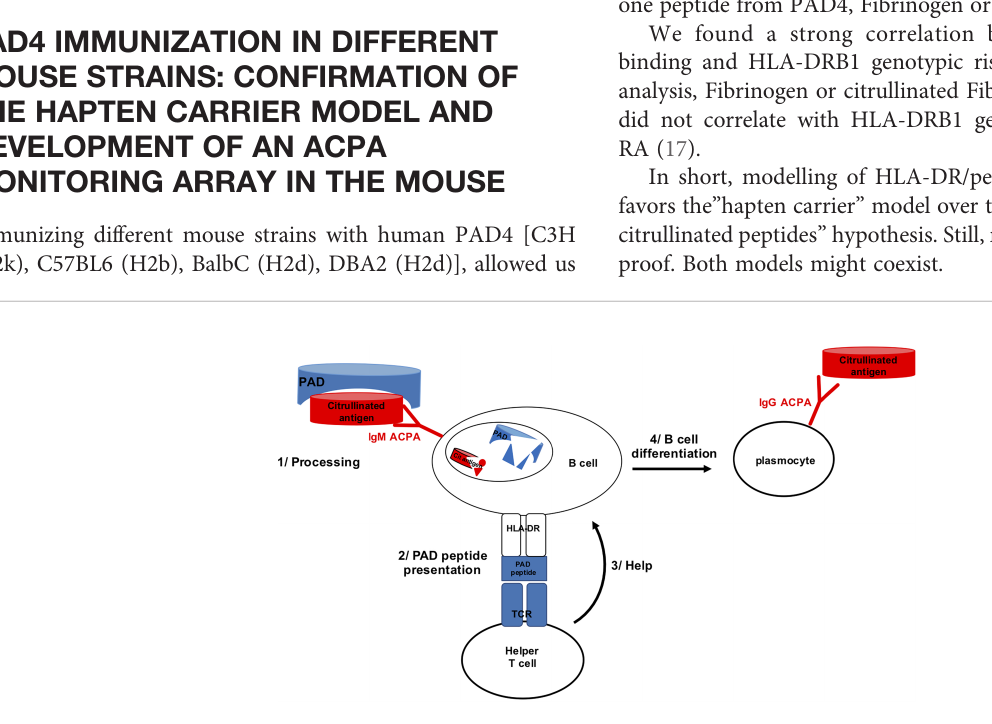
FIGURE 1 | B cell speci fi c for citrullinated epitope on PAD bound peptide can process PAD and present PAD peptide to PAD speci fi c helper T